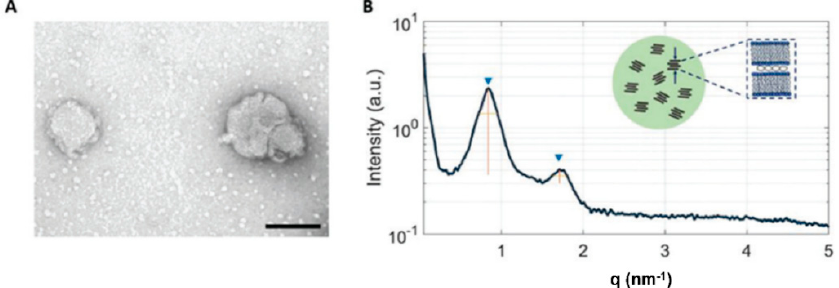
Figure 5. ( A ) TEM image of PEGylated nanoparticles (scale bar = 100 nm). ( B ) Scattering pattern of PEG-ylated nanoparticles. Inset: cartoon describing the nanostructure with multiple randomly oriented scattering domains. The broad peaks ( (cid:72) ) show the lamellar periodicity along the normal to the lipid bilayer, which includes the contribution of the membrane thickness and of the thickness of the water/DNA layer. (Reproduced with permission from Ref. [48]).